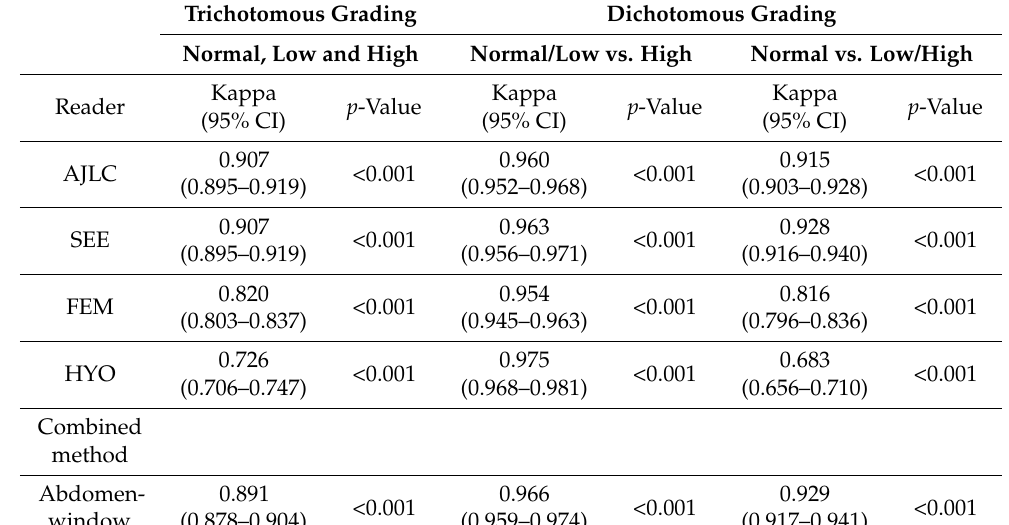
Table 3. Internal test set classifications using trichotomous and dichotomous Bilsky gradings on staging CT. Trichotomous Grading Dichotomous Grading Normal, Low and High Normal/Low vs. High Normal vs.